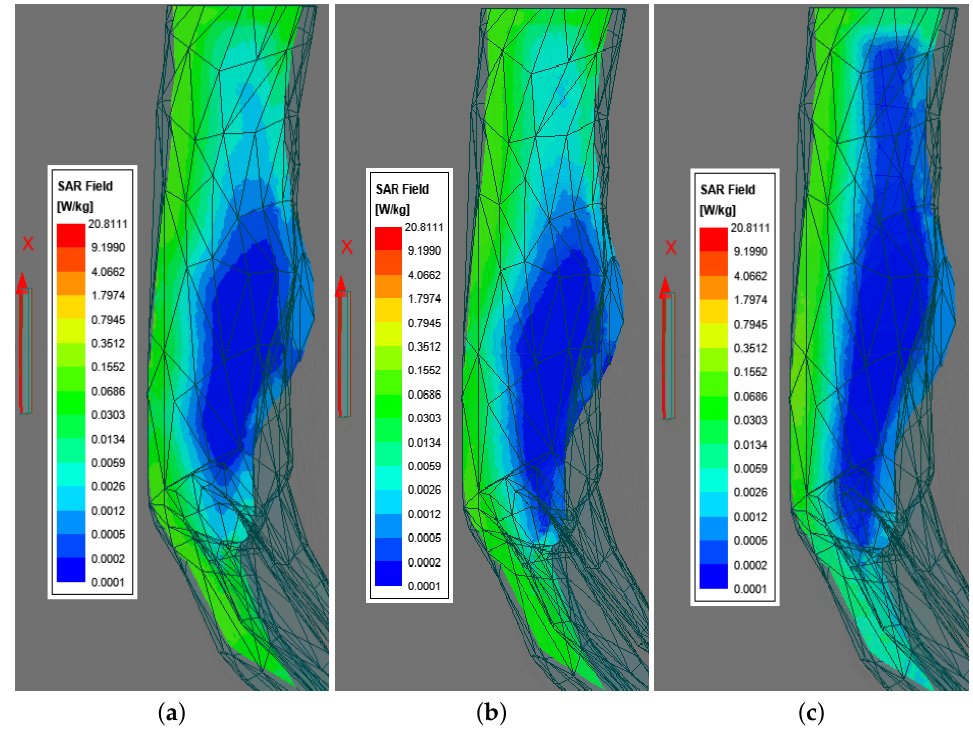
Figure 23. SAR avg plot on the XoZ -plane when d ant = 40 mm. ( a ) SAR avg at 5.8 GHz; ( b ) SAR avg at 6.2 GHz; and ( c ) SAR avg at 8.4